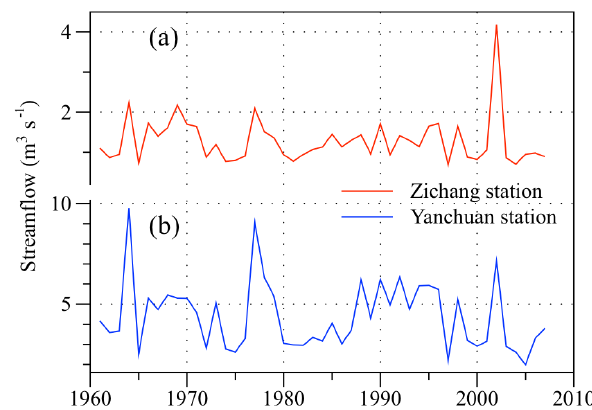
Figure 3. Annual changes of streamflow at Zichang and Yanchuan stations during the period of